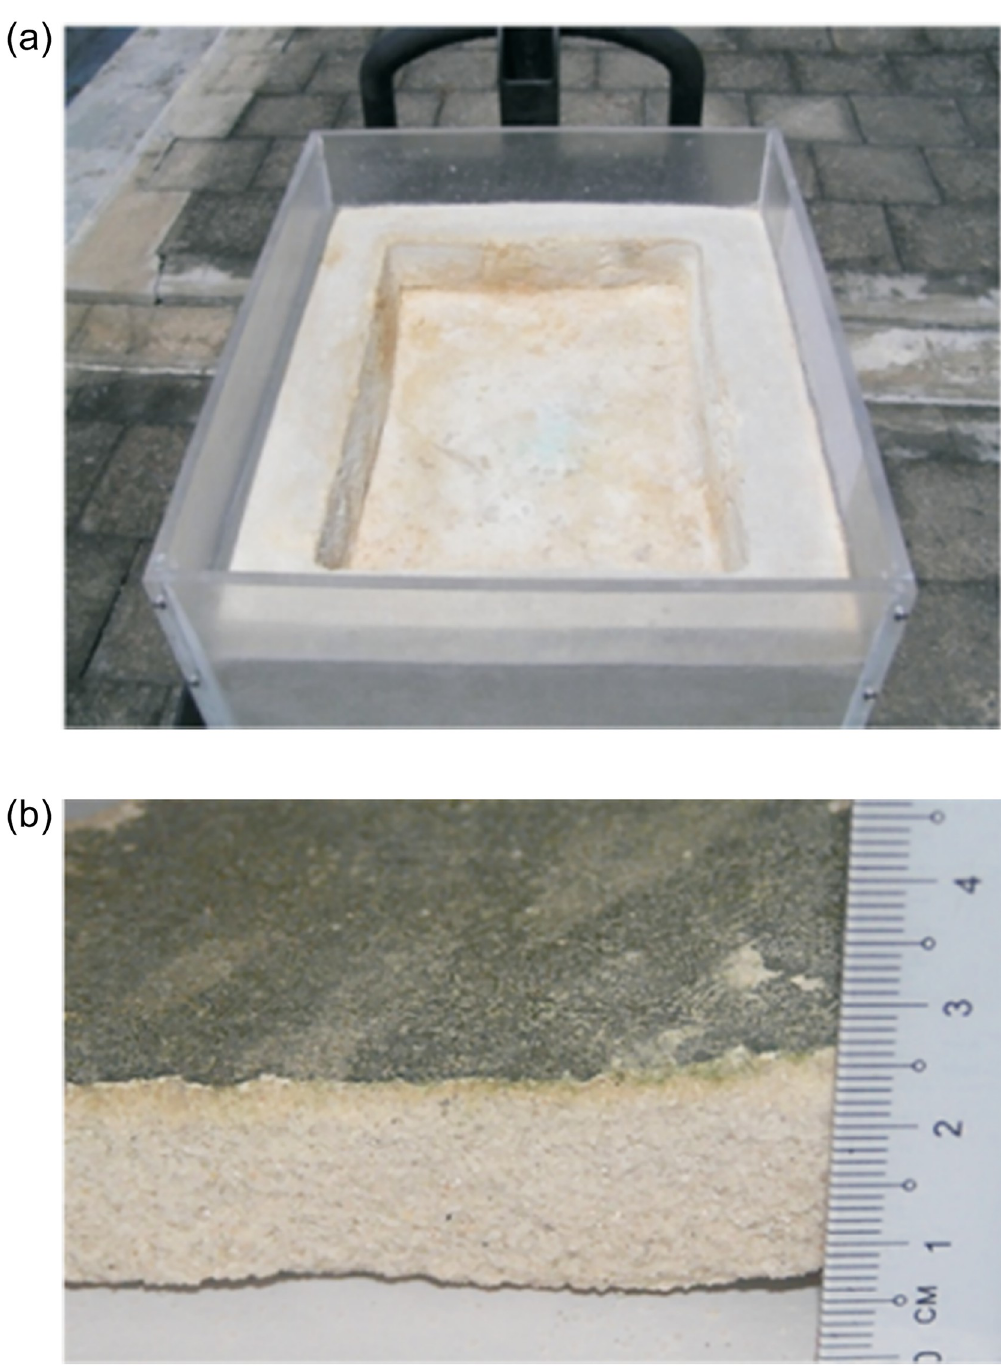
Fig 10. MICP application pool construction. (a): after treatment;(b) cross-sectional view of the bottom of the pond after cultivation of algae.